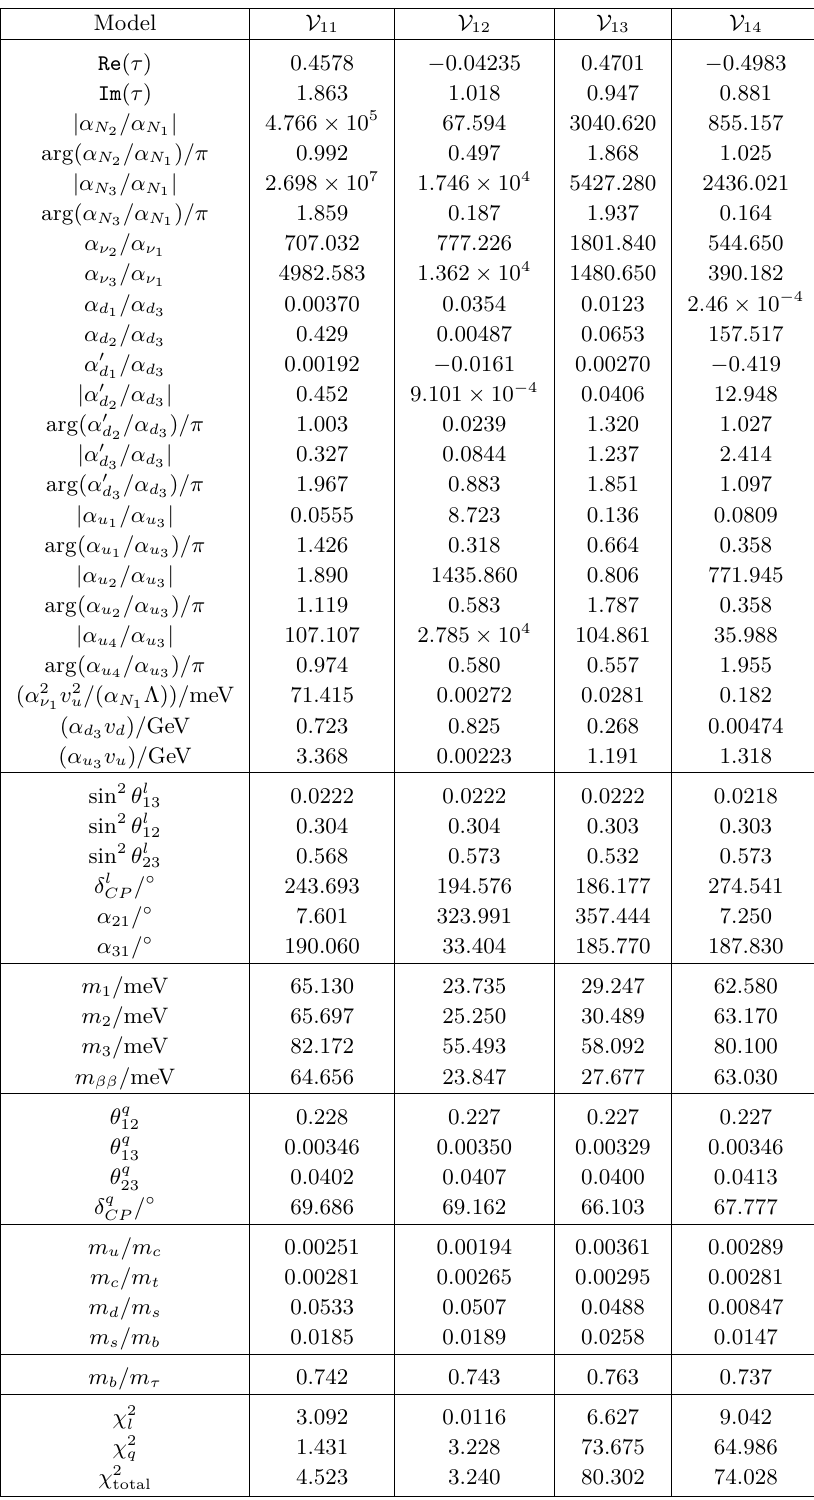
Table 11 . The best fit values of the free parameters and the corresponding predictions for lepton and quark mixing parameters and fermion masses for the phenomenologically viable models of Type-V (continuation of table